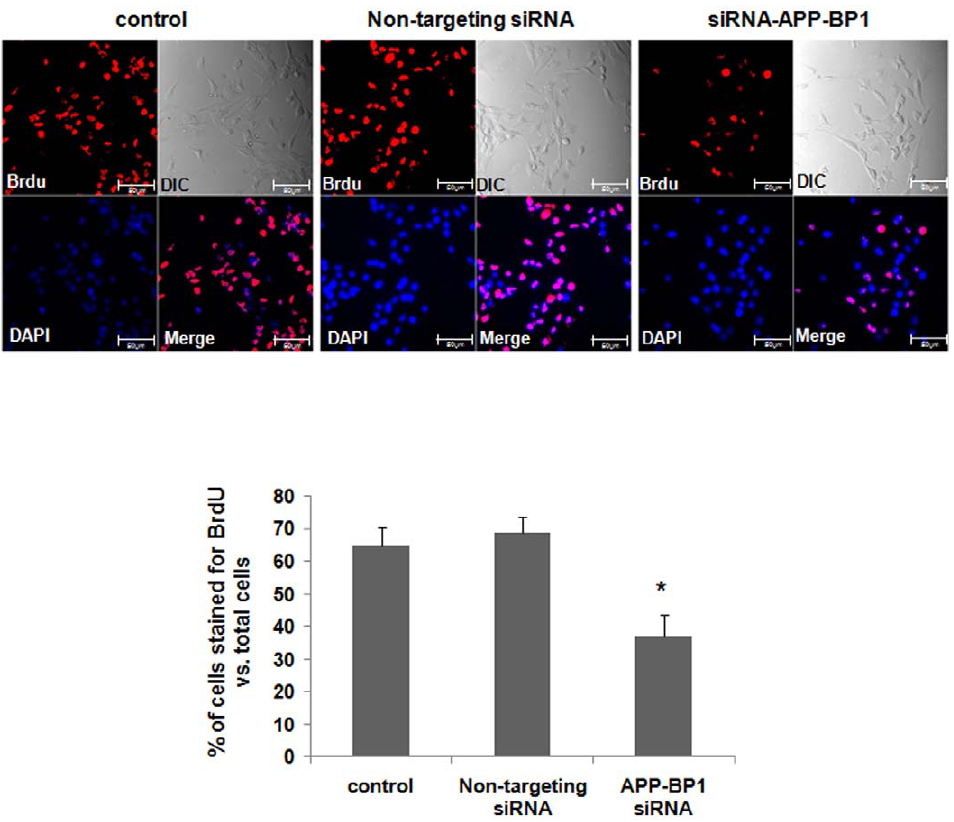
Figure 2. siRNA-mediated APP-BP1 knock-down significantly decreases BrdU-incorporated fetal neural stem cells. Fetal neural stem cells were subcultured in 6-well plates, in proliferating media, and then treated the cells with 10 nM siRNAs. After 24 h, the cells were treated with BrdU (1 m M) for 24 h. We then dissociated the neurospheres, and transferred the cells to new 6-well plates with 12 mm glass coverslips pre-coated with laminin (20 m g/ml). The cells were cultured in the differentiation media without growth factors for 30 min and assessed with immunocytochemistry using an anti BrdU and Cy3-secondary antibodies. DAPI (1 m M) staining shows the location of the nucleus (blue). DIC represents differential image contrast. BrdU immunoreactive cells were calculated in five independent experiments (10 fields were evaluated per each experiment) with respect to the ratio of BrdU stained cells to total cells. Data are expressed as mean 6 SEM values. One-way ANOVA was used to determine statistical significance at p , 0.05 by post hoc analysis via Duncan’s test. Scale bars=50 m m.